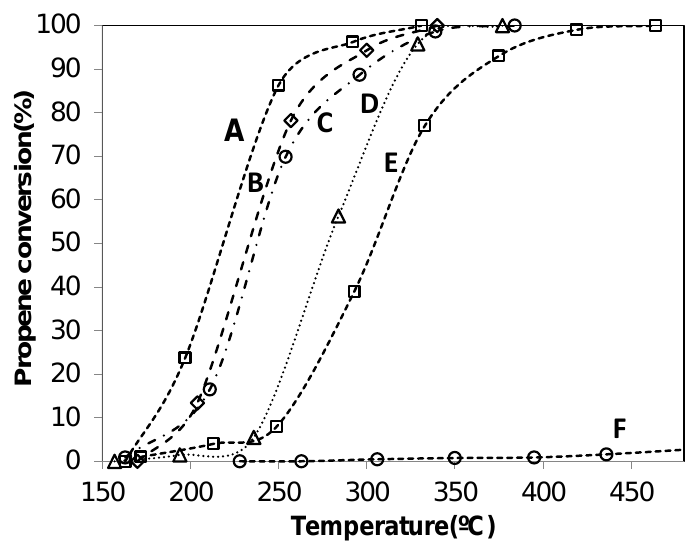
Figure 4. Propene to CO 2 conversion vs. temperature. (A) PdCo-ZnAl; (B) PdCu-ZnAl; (C) Pd-ZnAl; (D) Co-ZnAl; (E) Cu-ZnAl; (F) without catalyst. Table 5. Comparison of deep propene oxidation activity for different catalysts.